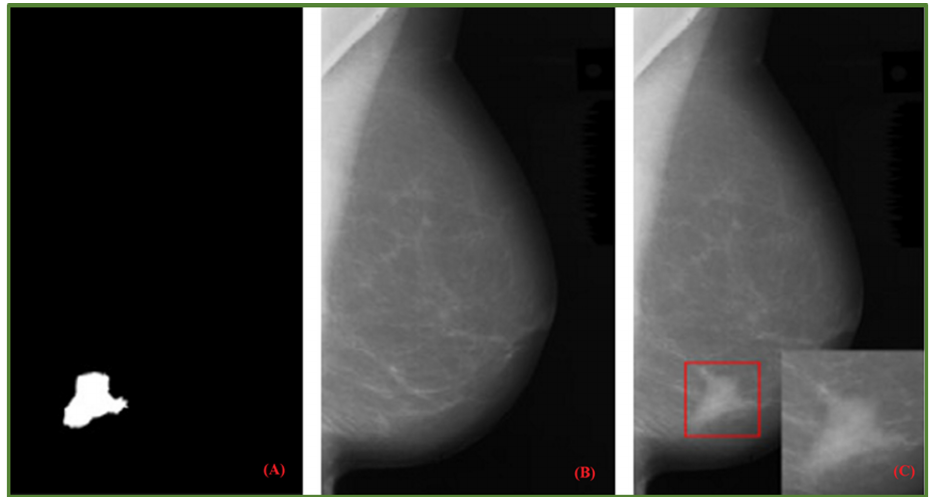
Figure 8. Given mask image ( A ); normal mammogram image ( B ); generated mammogram image with synthetic mask ( C )